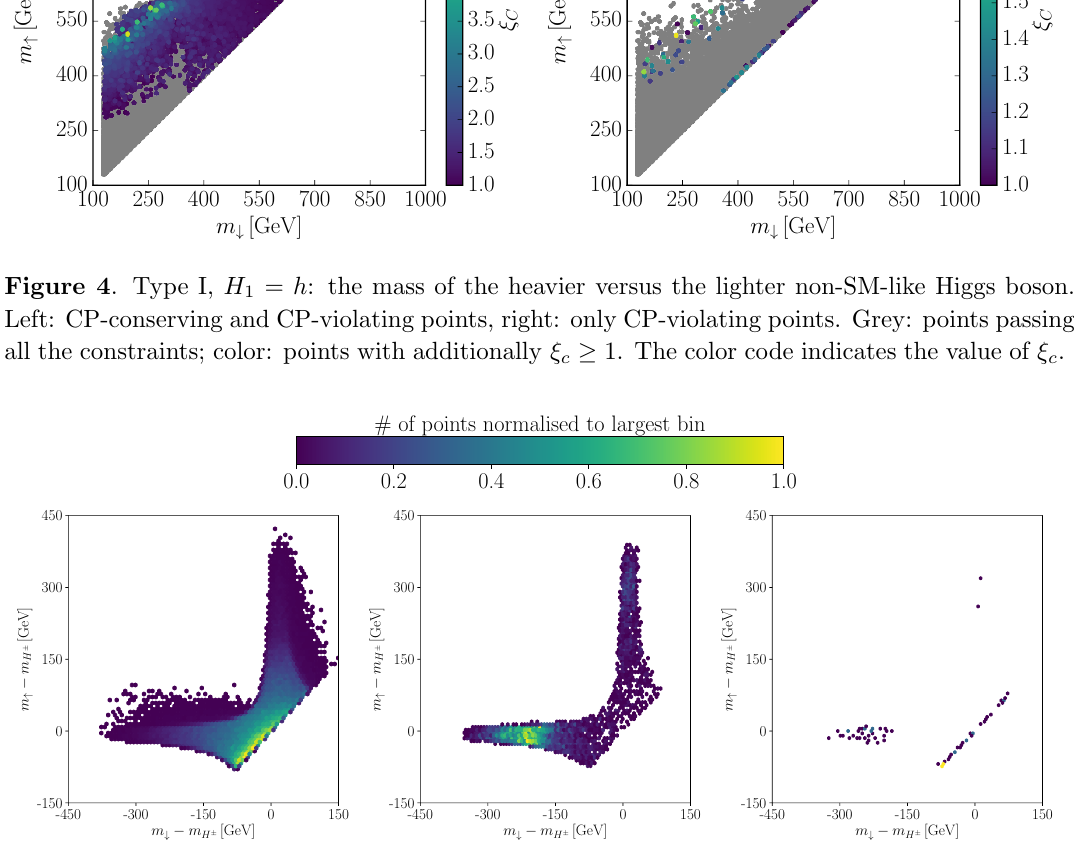
Figure 5 . Type I, H 1 = h : the mass di(cid:11)erence m " (cid:0) m H (cid:6) versus m # (cid:0) m H (cid:6) . The colour code shows the relative frequency of left: all points passing the constraints; middle: all points with a strong PT and CP conservation; right: all points with (cid:24) c 1 and explicit CP (cid:21)